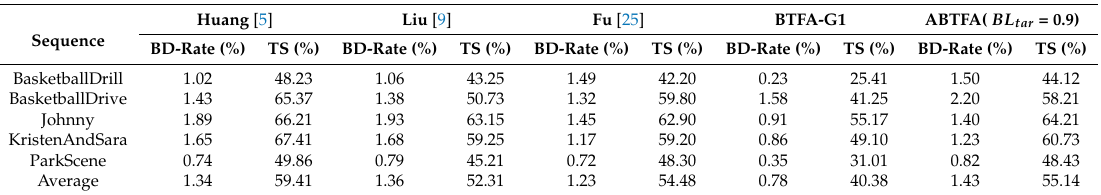
Table 7. BD-rate loss and time saving comparison between the proposed algorithm and the most recent